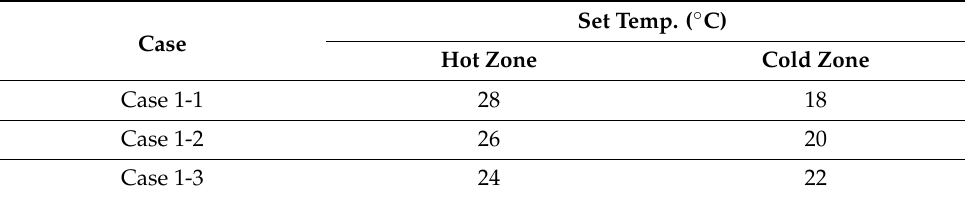
Table 1. Cases for method written in Section 2.3.1.